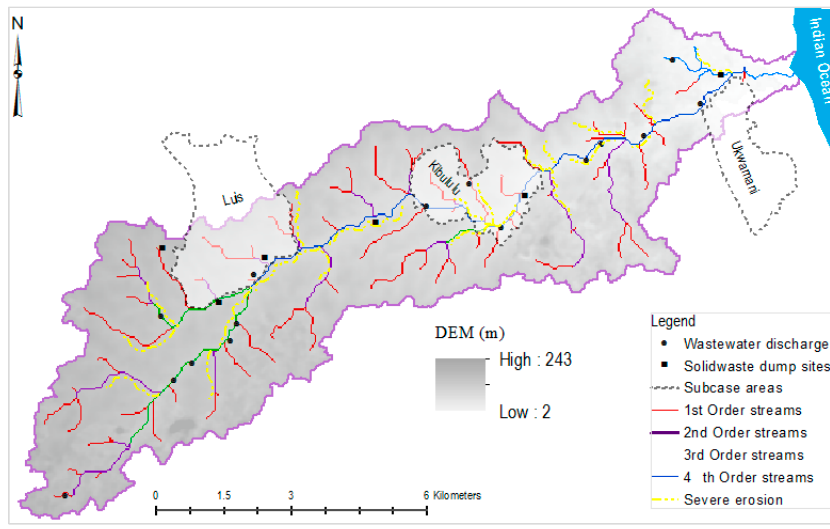
Figure 2. Delineation and topography of Mbezi River catchment, occurrence and ranking of streams, based on GIS, and locations of erosion and pollution sources based on field investigations.